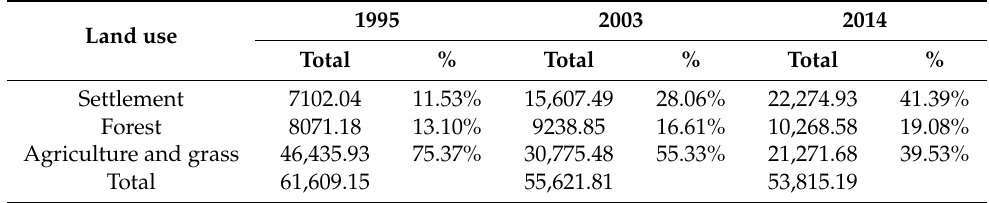
Table 4. Annual gross primary production (GPP) in Denpasar from 1995 to 2014 for each different land use as a total (tC year − 1 ) and a percentage of the